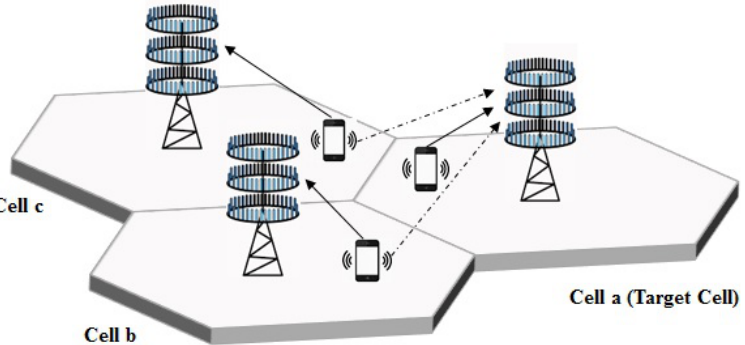
Figure 1. The effect of pilot contamination in multicell massive MIMO systems at a cell a , where the solid line represents the direct gain and the dotted line represents the inter-cell